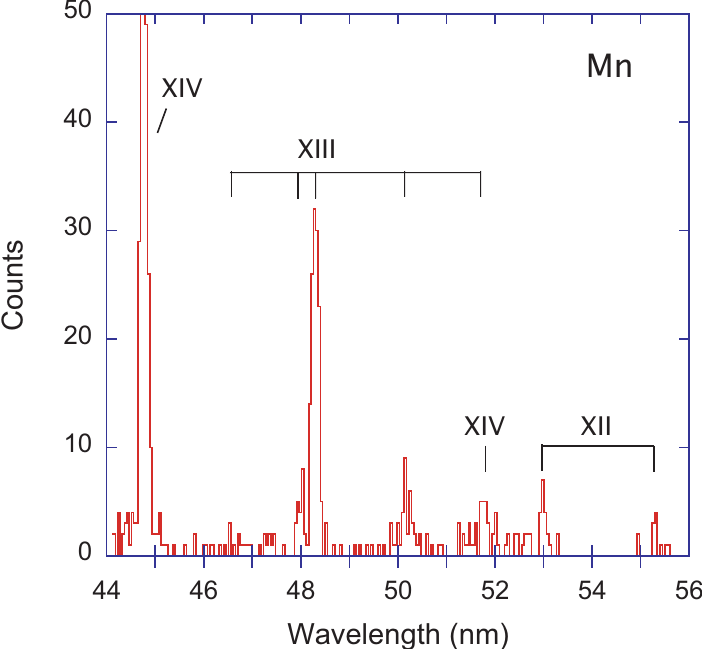
Figure 20. Beam-foil spectrum of Mn at an ion beam energy of 20MeV. Observation at a position 175mm downstream of the foil (delay 20.8ns). Line width (FWHM) 0.15nm. The strongest lines are identified by the spectrum number. Most of the lines in this spectrum originate from 3s–3p intercombination transitions in Mg-, Al- and Si-like